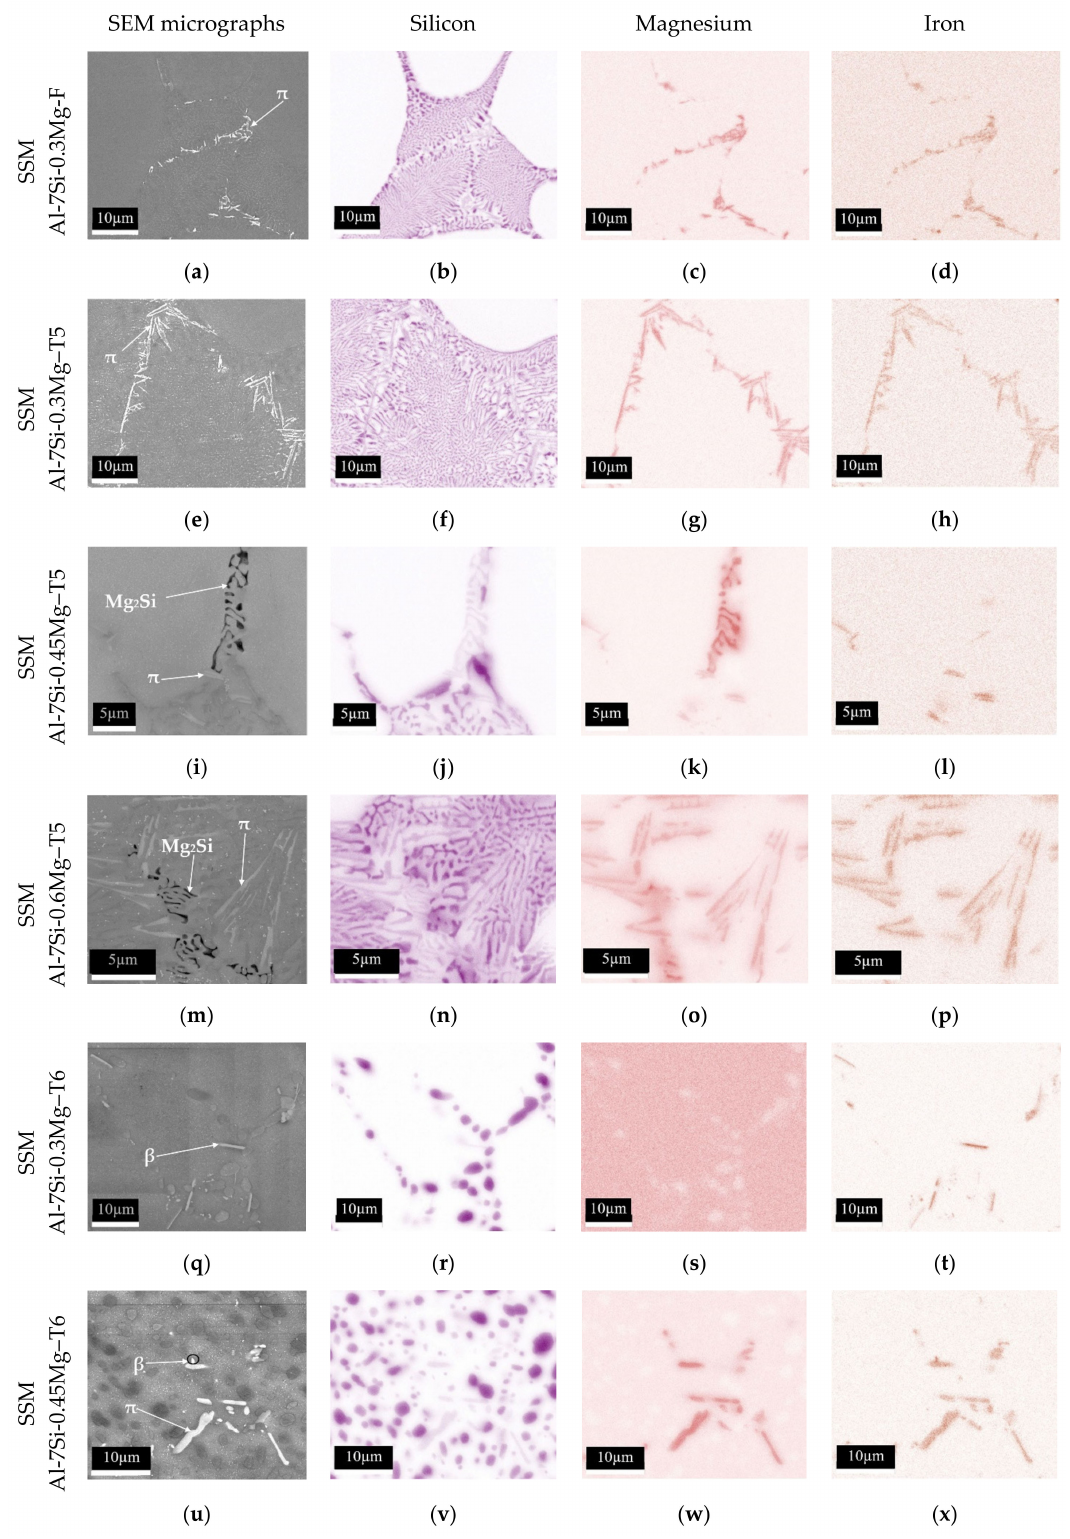
Figure 8. SEM micrographs and respective EDS mapping showing silicon, magnesium and iron distribution in SSM Al-7Si-Mg castings: ( a–d) SSM Al-7Si-0.3Mg-F, ( e–h ) SSM Al-7Si-0.3Mg–T5, ( i–l ) SSM Al-7Si-0.45Mg–T5, ( m–p ) SSM Al-7Si-0.6Mg–T5, ( q–t ) SSM Al-7Si-0.3Mg–T6 and ( u–x ) SSM Al-7Si-0.45Mg–T6 (Color figure